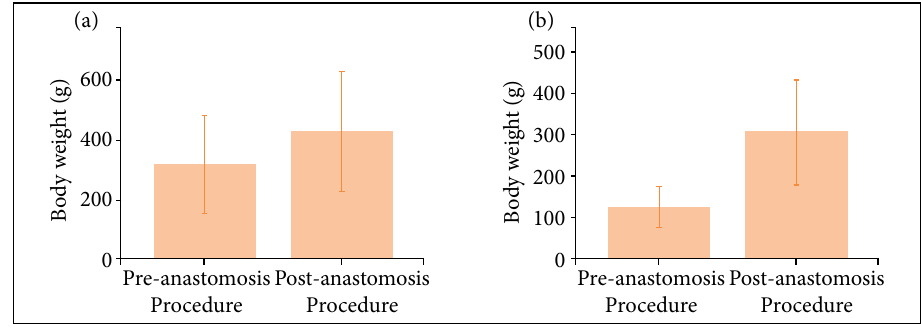
Figure 1 - Weights of (a) adult and (b) young rats before and after the anastomosis procedure (p = 0.01 and p < 0.001, respectively).